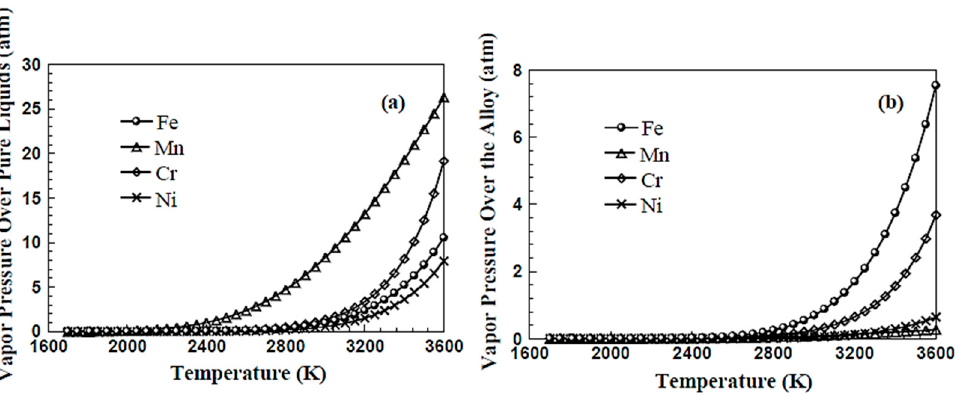
Figure 7. Equilibrium vapor pressures of the four alloying elements ( a ) over the respective pure liquids, and ( b ) over the alloy at different temperatures [78]. (Reused from ref. [78], copyright (2003), Sandia National Laboratories).